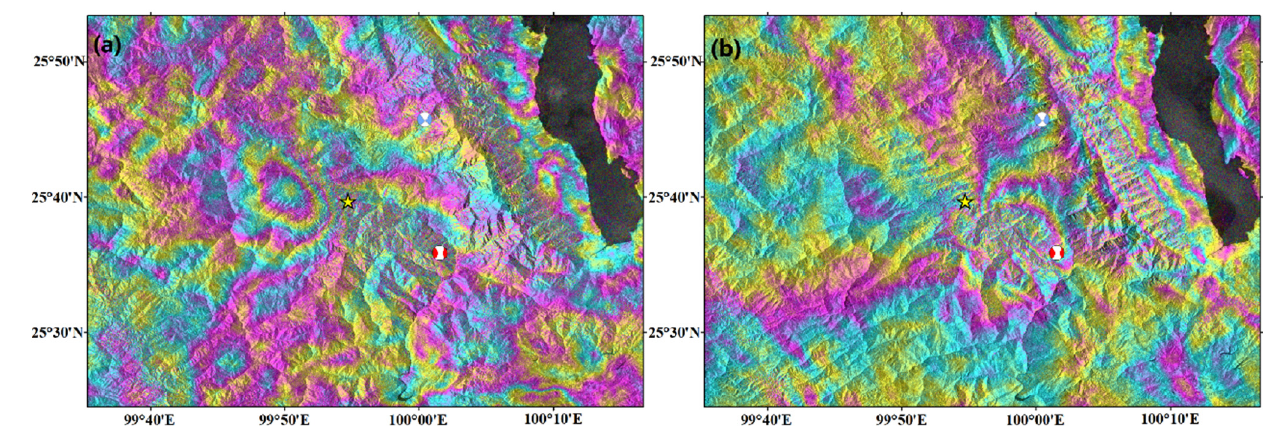
Figure 3. Ascending and descending interferograms of the 2021 Yangbi M W 6.1 earthquake: ( a ) interferogram in the ascending track; ( b ) interferogram in the descending track.